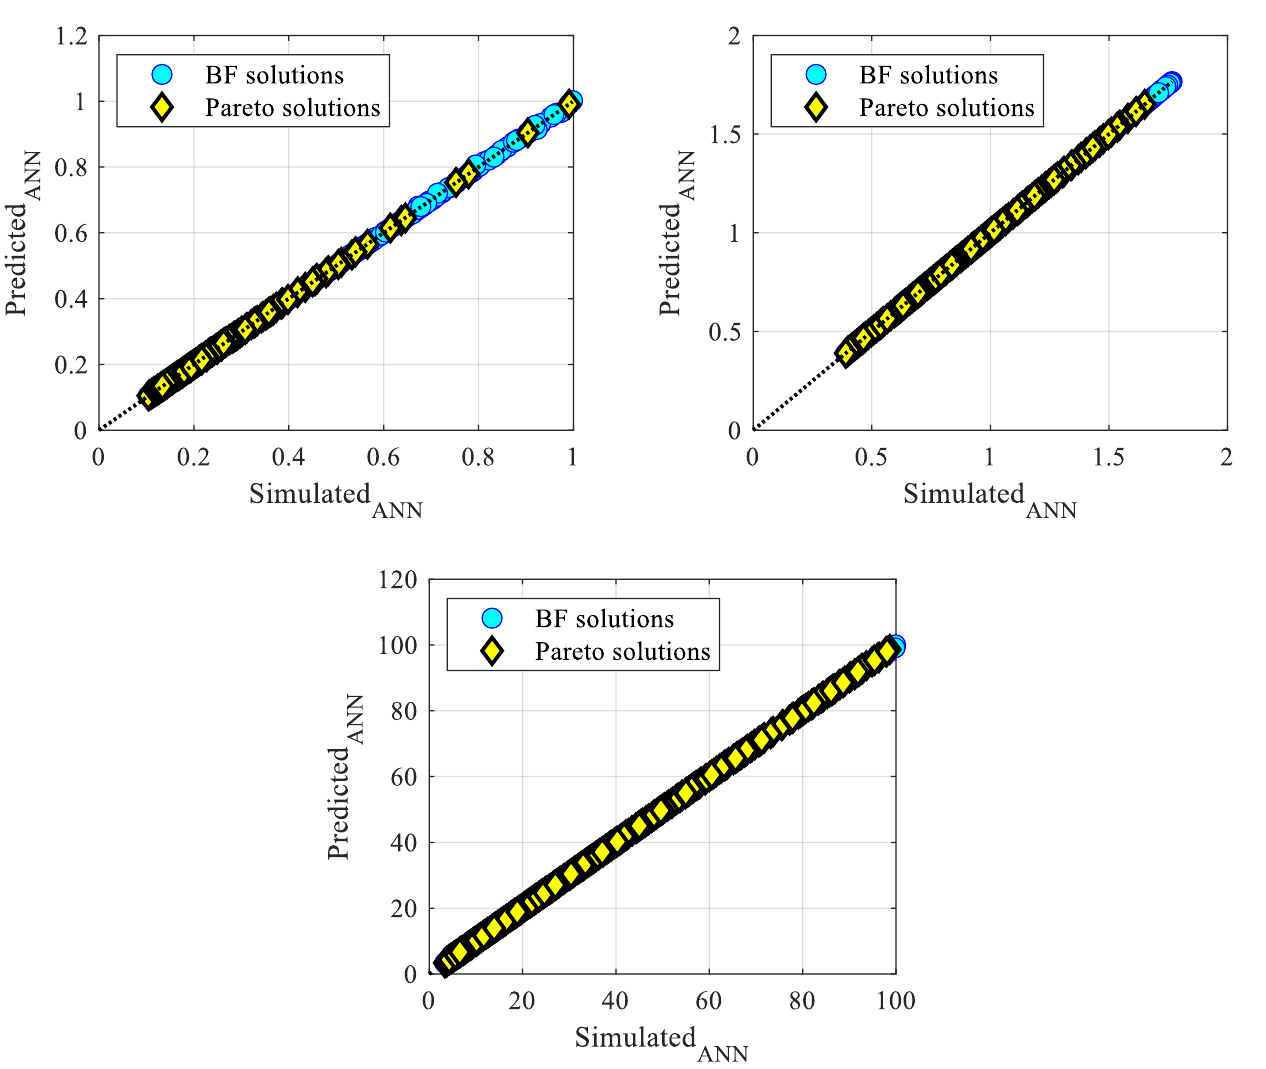
Figure 6. Comparisons between predicted (artificial neural network) and simulated solutions for both BF and Pareto solutions the three different objective functions investigated ( j = 1, 2, and 3, from the left, to the right, to the bottom).